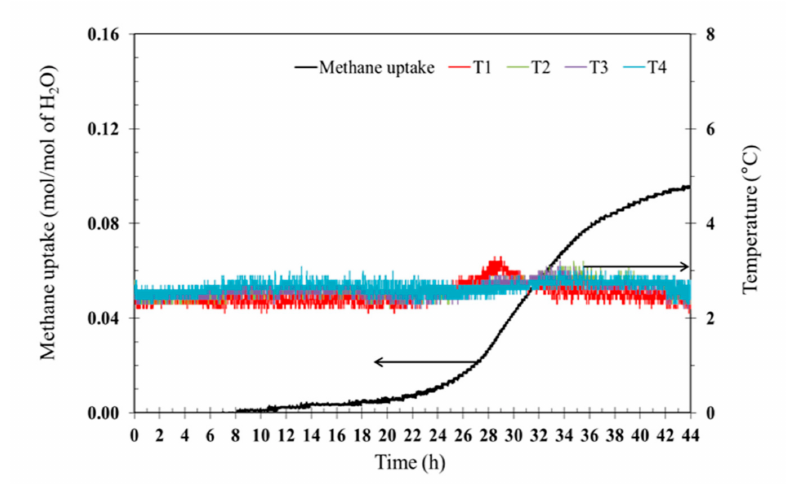
Figure 4. Gas uptake and temperature profiles of forming the TBAB semiclathrate hydrate at 2.5 ◦ C and 8 MPa in the batch operation ( w = 0.025) (Experiment 2, Table